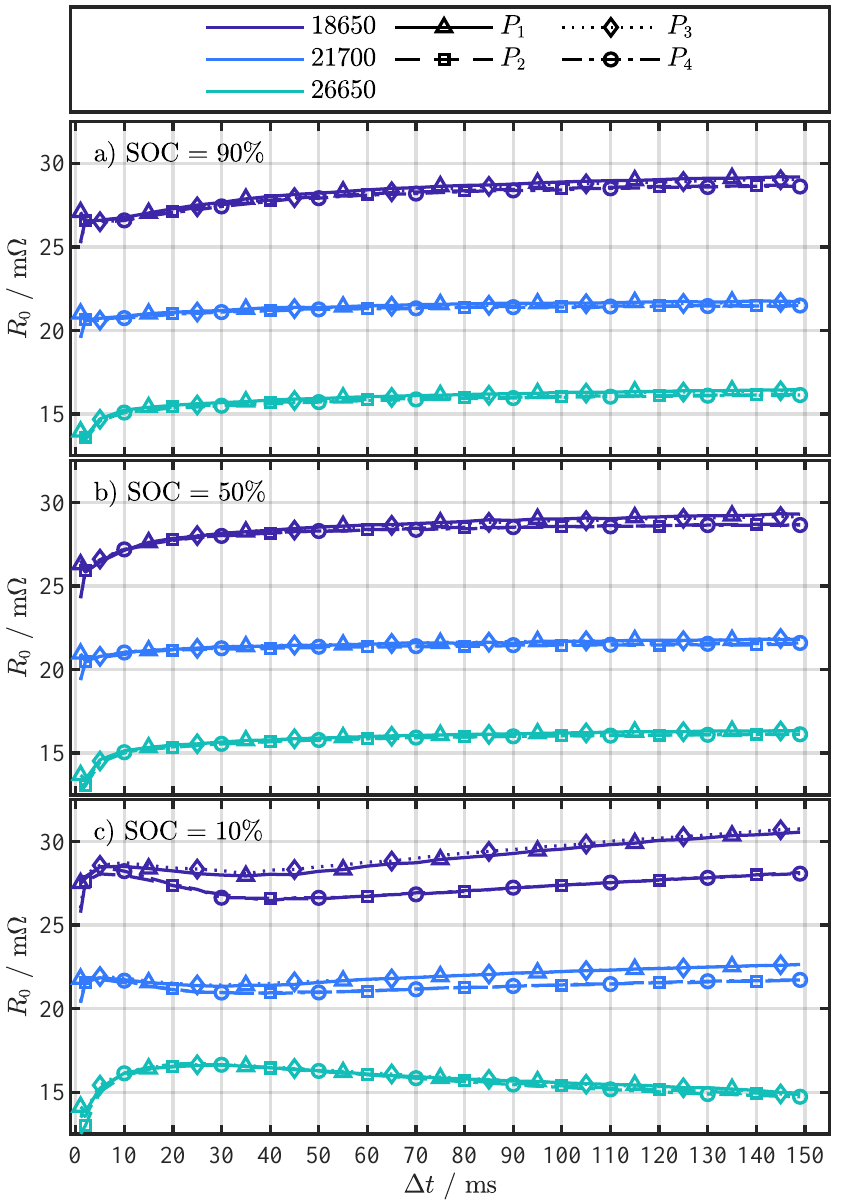
Figure A3. Fitting results for Equation (4) for the parameter R 0 , each investigated cell format, and the four different pulse current types ( P 1 to P 4 ) at the SOCs 90% ( a ), 50% ( b ), and 10% ( c